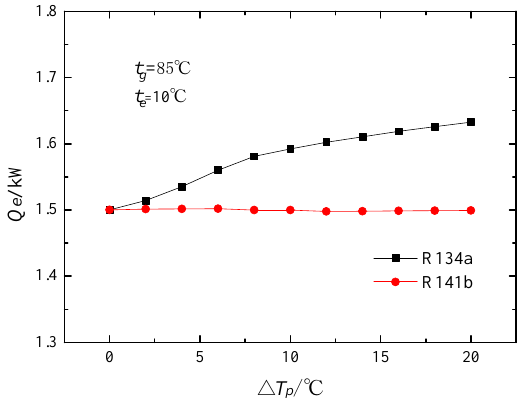
Figure 14. Cooling capacity versus the primary superheating (cid:52) T p .